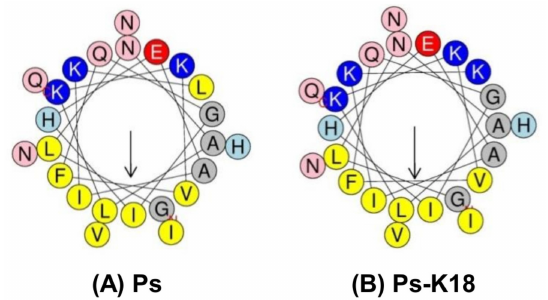
Figure 1. Helical-wheel diagrams of Ps and Ps-K18 using HeliQuest (http: // heliquest.ipmc.cnrs.fr / ). Helical-wheel diagrams of ( A ) Ps and ( B ) Ps-K18. Positively charged residues are shown in blue, negatively charged residues in red, and hydrophobic residues in yellow at the bottom of the wheel. In addition, Gly and Ala are shown in gray, Asn and Gln in pink, and His in sky blue. The arrows are presented based on the helical hydrophobic